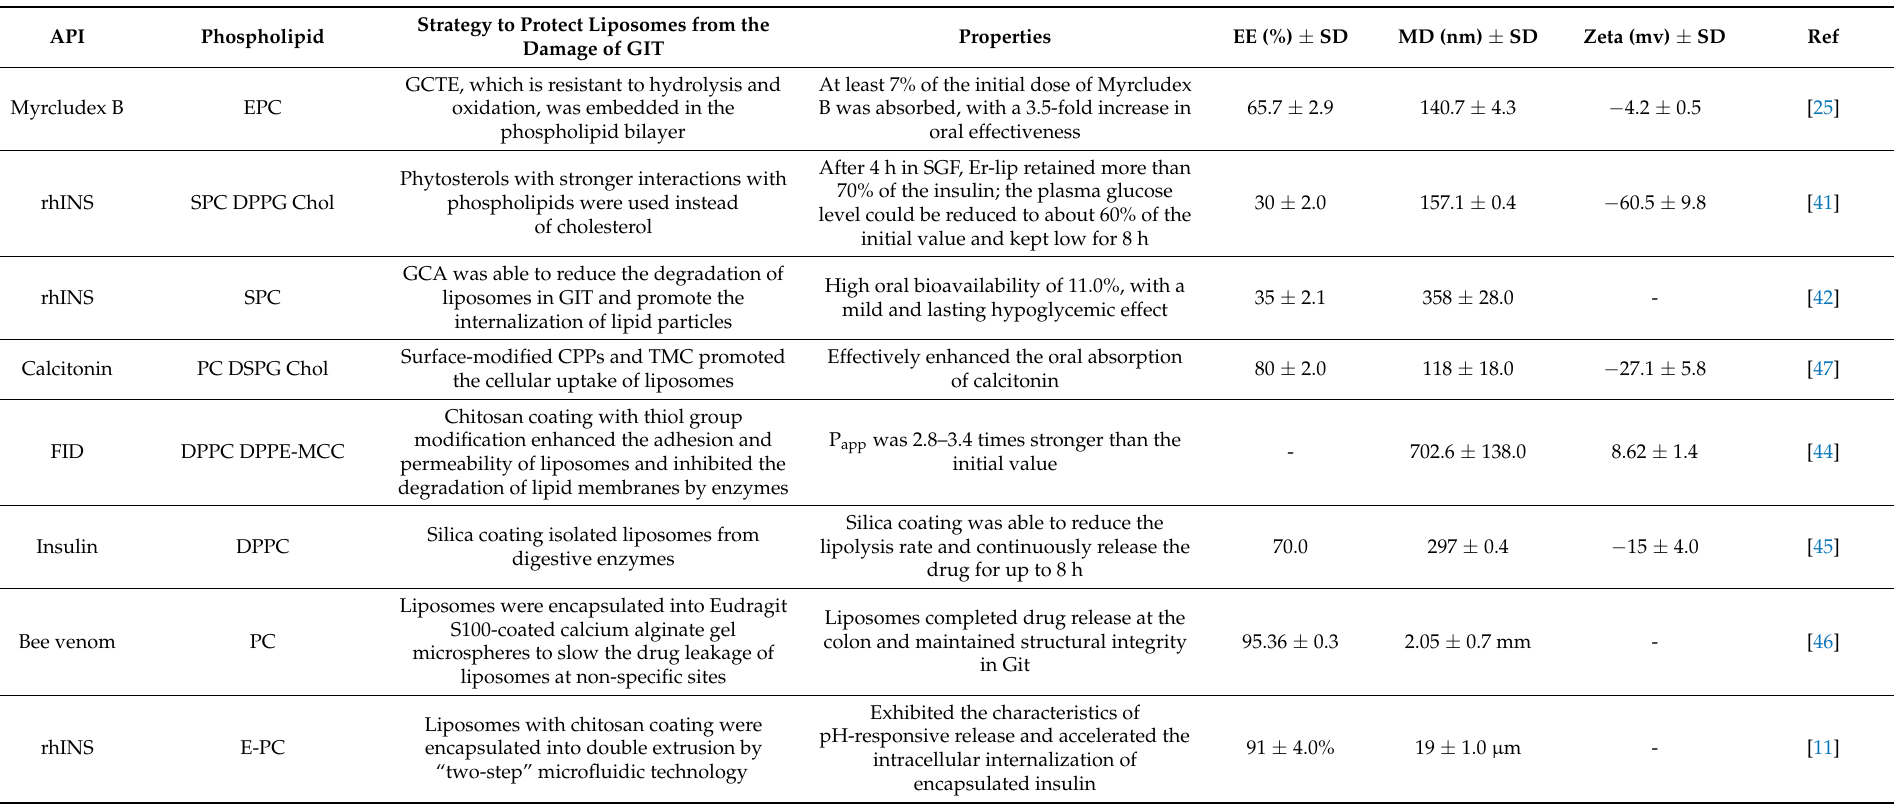
Table 2. The composition of liposomes and the enzymatic stability of both the encapsulated peptide/protein and the